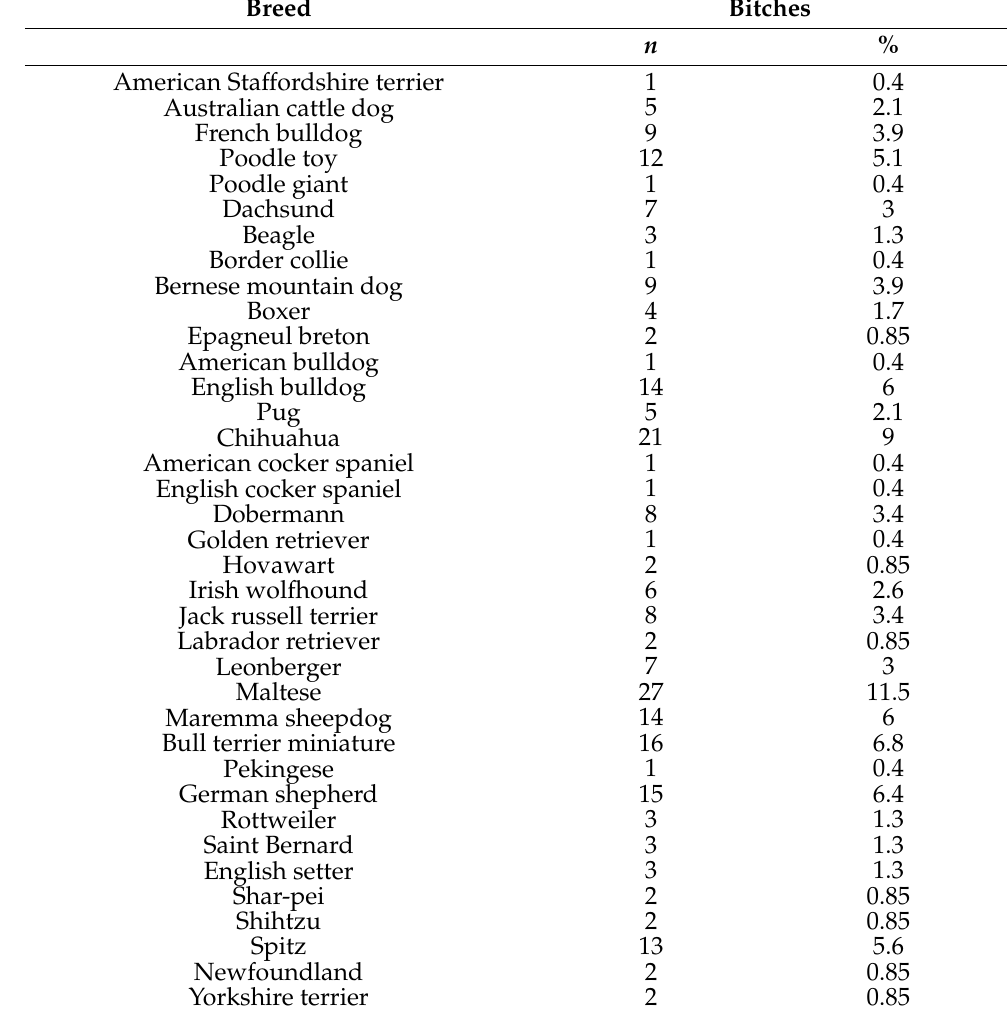
Table 1. Breed distribution (number and %) of the 234 bitches/litters enrolled in the present study.